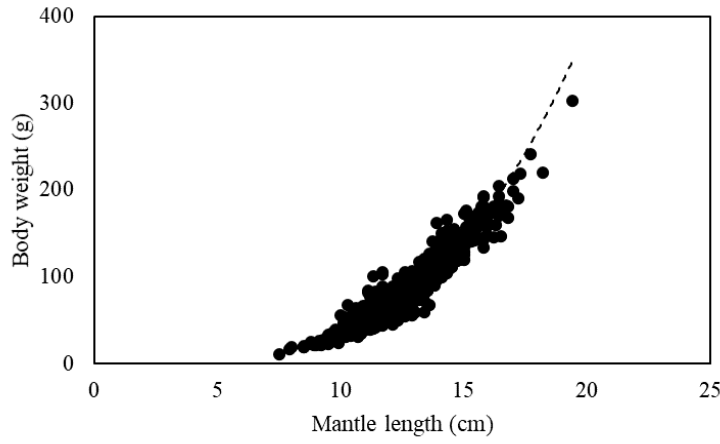
Figure 6. Relationship of mantle length and body weight of S. oualaniensis. The age of the oldest individual was 90 days with a mantle length of 15.4 cm and the youngest individual was 45 days old with a mantle length of 8.4 cm. The dominant age range was 50 to 80 days, accounting for 92.7% of the total (Figure 7). The average mantle length of S. oualaniensis was 9.5 cm in the range of 50–59 days, 12.0 cm in the range of 60–69 days, and 13.5 cm in the range of 70–79 days. Within the dominant age group, the S. oualaniensis grew about 2.0 cm every 10 days.